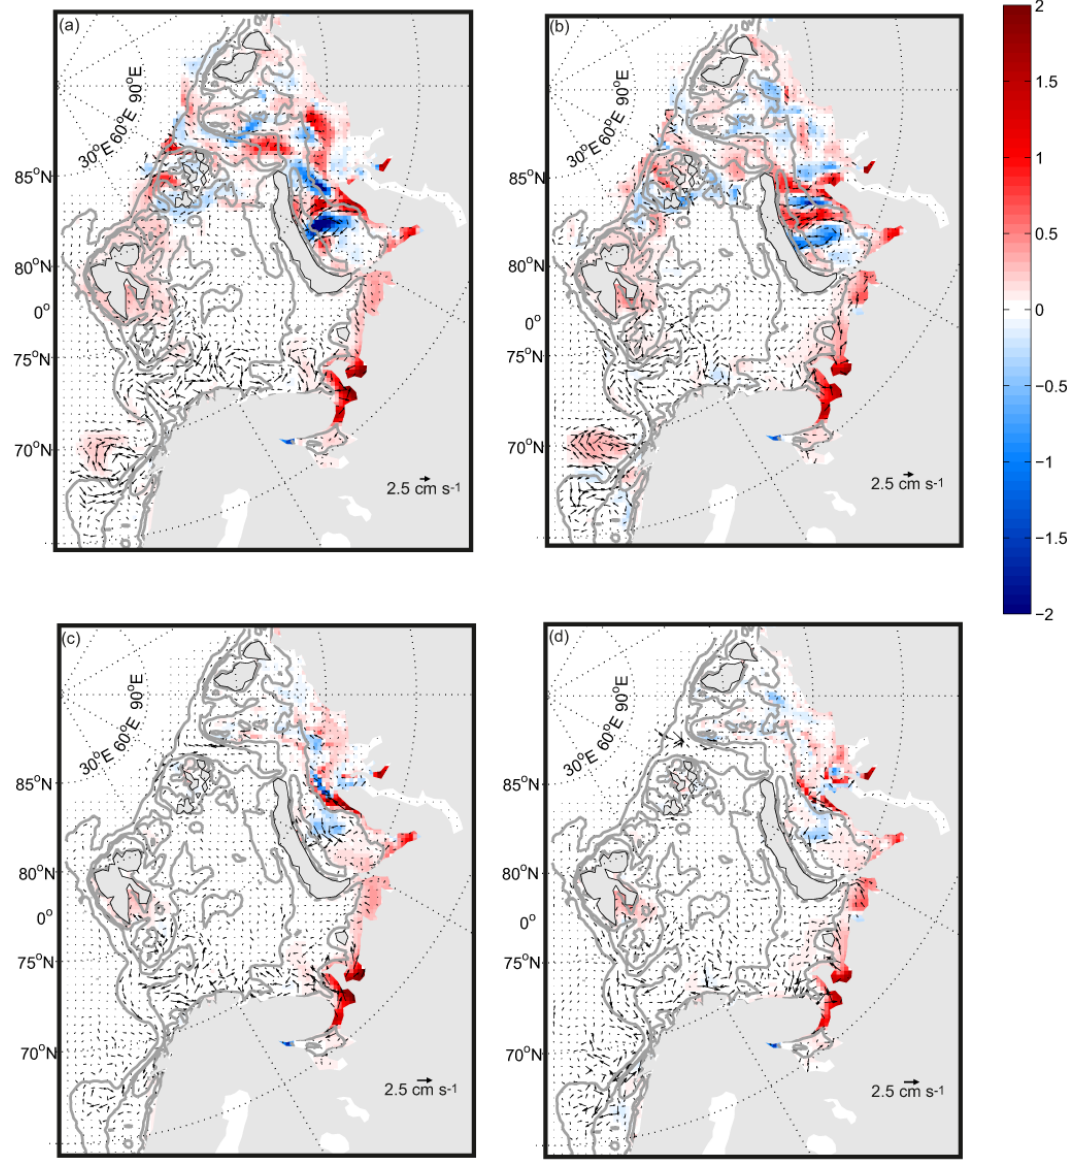
Fig. 8. Mean difference in sea surface salinity (color contours) and velocity (arrows) between the model run with tides and the control run for (a) winter and (b) summer from the fifth year of model integration. Mean difference in sea bottom salinity (color contours) and velocity (arrows) for (c) winter and (d) summer from the fifth year of model integration. Winter and summer as defined in Fig. 7. Positive values indicate the salinity is greater when tides are included in the model. The velocity vectors are capped at 2.5cms − 1